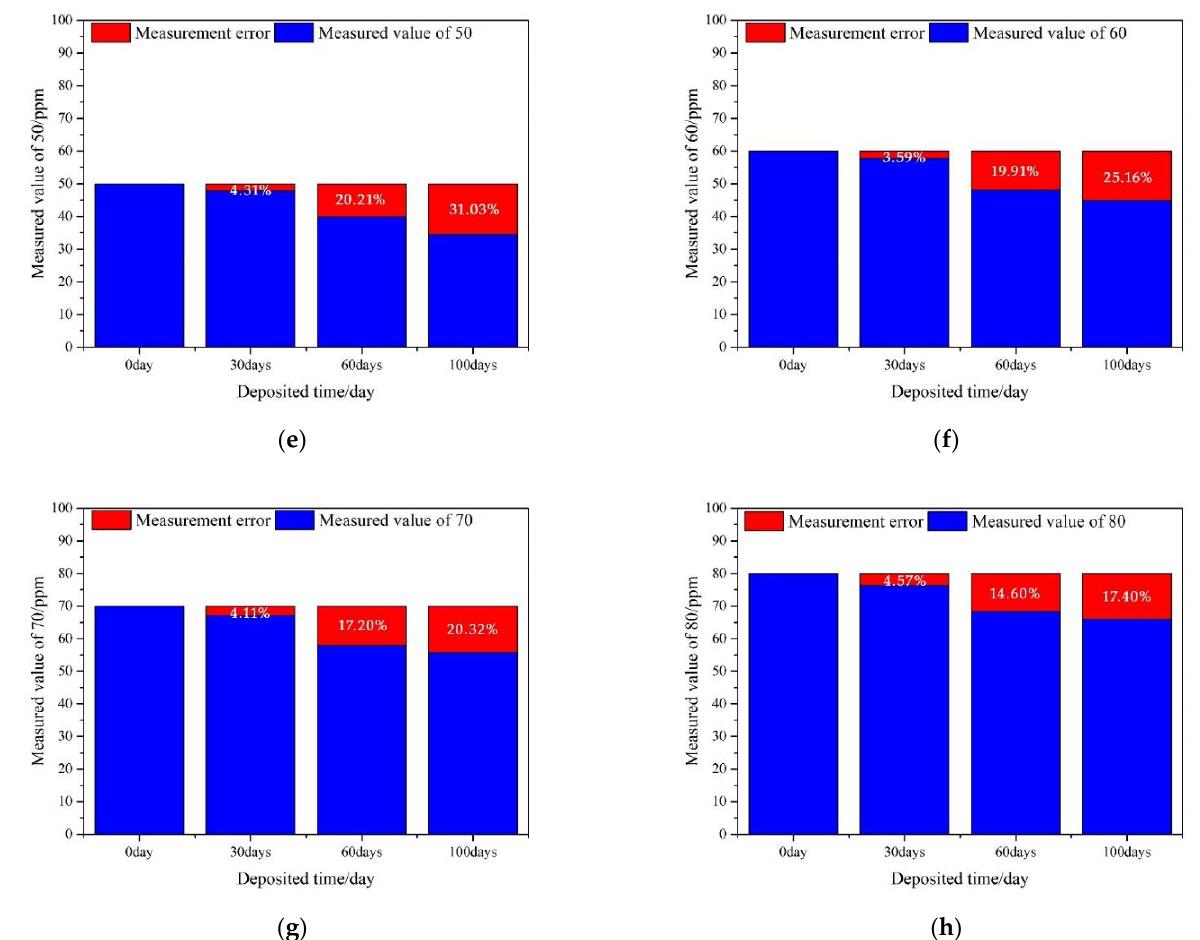
Figure 10. Measurement errors of sensors with different deposition times for the same concentration of SO 2 gas: ( a ) 10 ppm measurement error; ( b ) 20 ppm measurement error; ( c ) 30 ppm measurement error; ( d ) 40 ppm measurement error; ( e ) 50 ppm measurement error; ( f ) 60 ppm measurement error; ( g ) 70 ppm measurement error; ( h ) 80 ppm measurement error.